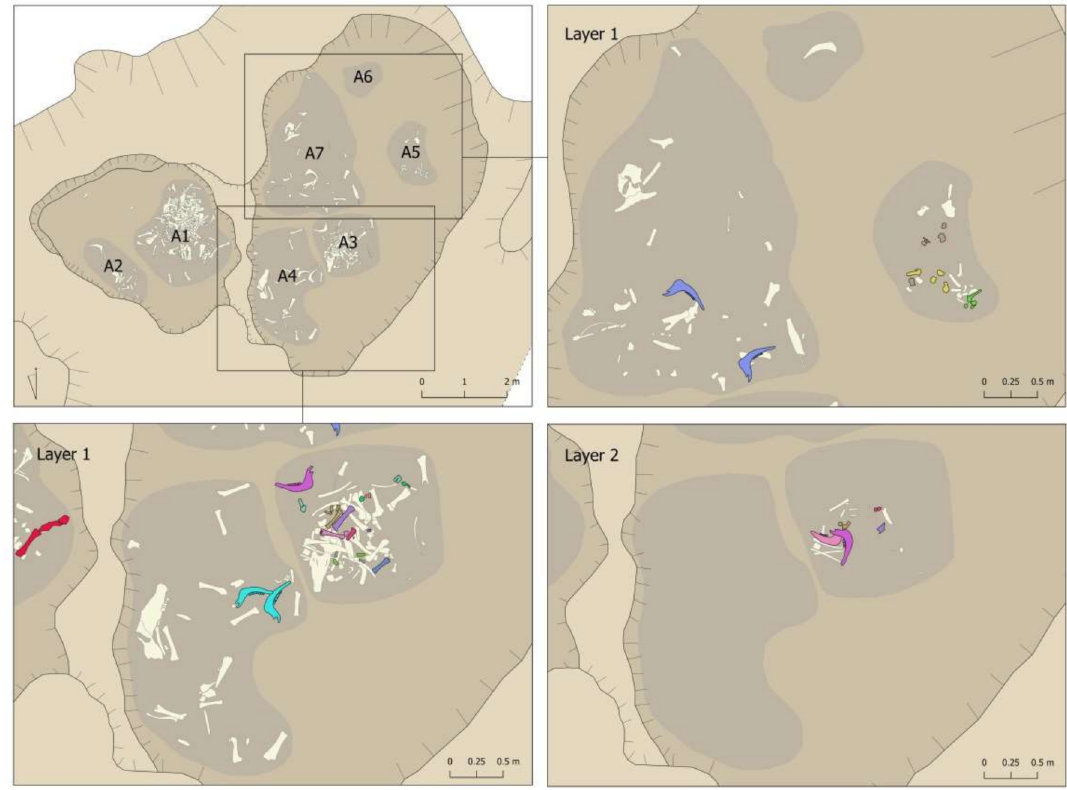
Figure 14. Connections documented in the different layers of Areas 3, 4, 5, 6, and 7 of the Vilauba